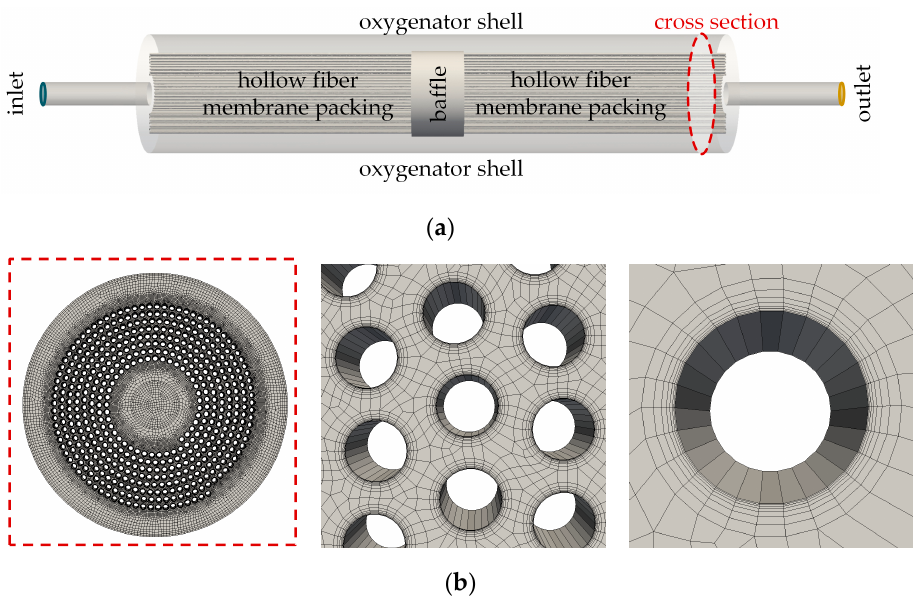
Figure 6. Geometry of CFD flow simulations: ( a ) Cross section of the prototype oxygenator, inside view; ( b ) cross section of the fiber packing with close up on the boundary layer mesh of the fibers.